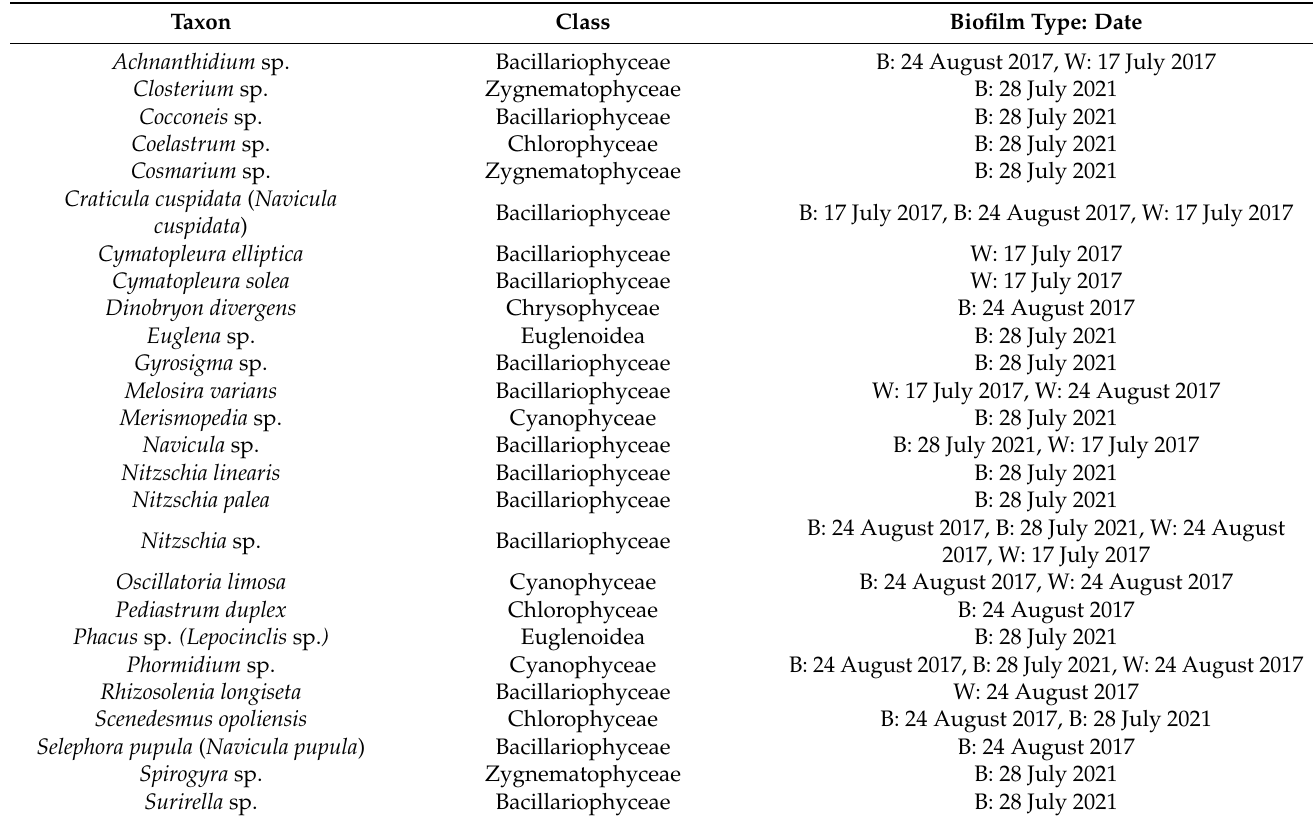
Table 4. Algae and cyanobacteria associated with biofilms at the Smrdljivec spring during sampling campaigns in the summers of 2017 and